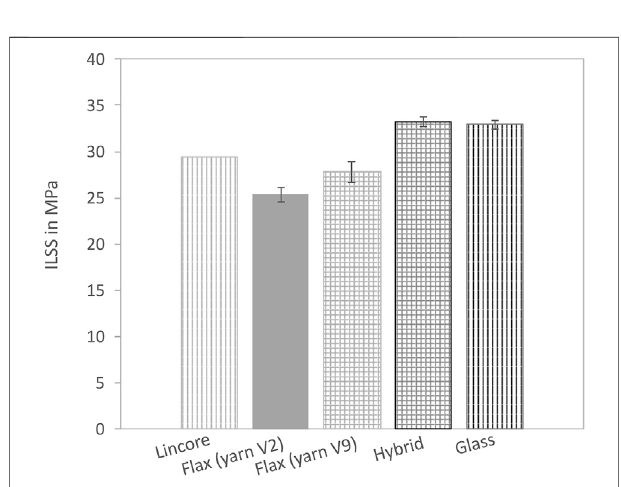
FIGURE 6 | Interlaminar shear strength (ILSS) of composite laminates (mean value ± standard deviation).